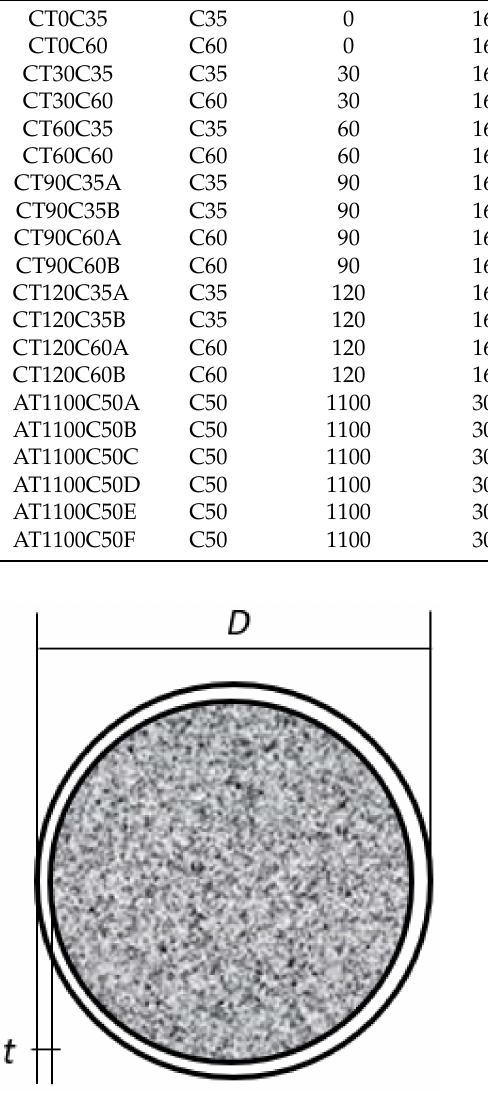
Figure 1. Cross section of CFST